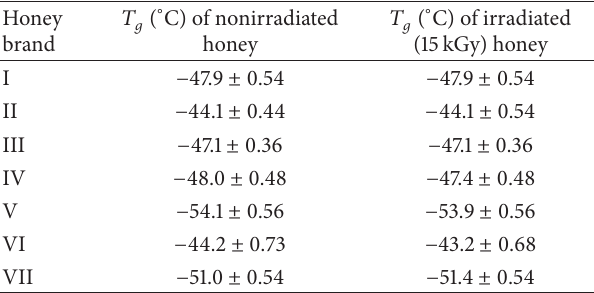
Table 3: Glass transition temperature ( 𝑇 𝑔 ) of different honey and effect of gamma radiation treatment.